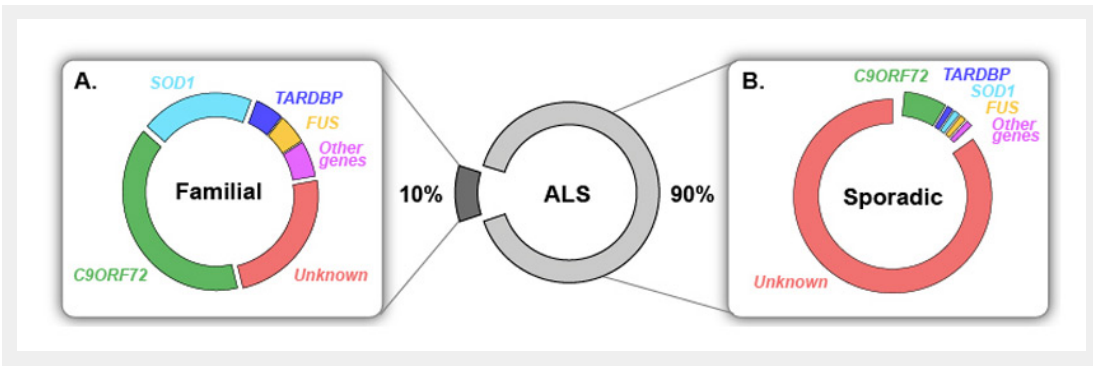
Known genetic causes in familial and sporadic ALS. Most ALS cases are sporadic (sALS) and only 10% are inherited, called familial (fALS). (A) 20% of fALS are caused by mutations in SOD1, which is the first known ALS-linked gene, identified in 1993. Mutations in the RNA/DNA-binding proteins TDP-43 and FUS cause a small fraction (~5%) of fALS each. Hexanucleotide repeat expansions in C9ORF72 are the most common genetic cause of ALS accounting for almost 40% of fALS in people of European ancestry. Several other genes have been identified as genetic causes of ALS and collectively today over 60% of fALS can be explained by known mutations. (B) While the aetiology of the vast majority of sALS remains unknown, mutations in genes known to cause fALS were identified in a small fraction of apparently sporadic patients. Most strikingly, hexanucleotide repeat expansions in C9ORF72 are causing approximately 7% of sALS without familial history in people of European